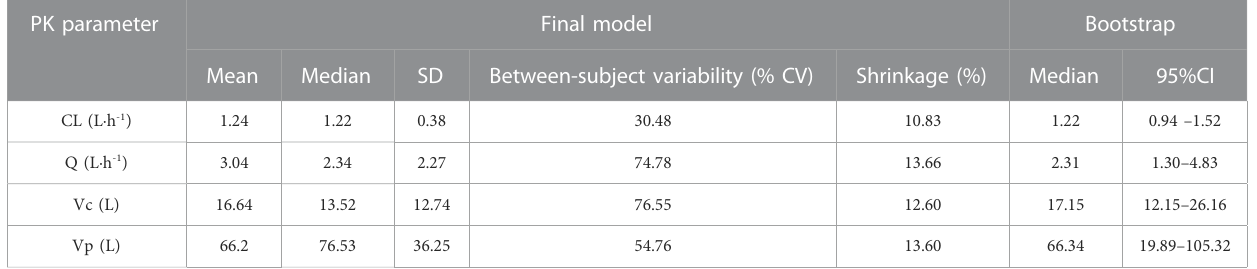
TABLE 3 PPK parameter estimates from model 6 for polymyxin